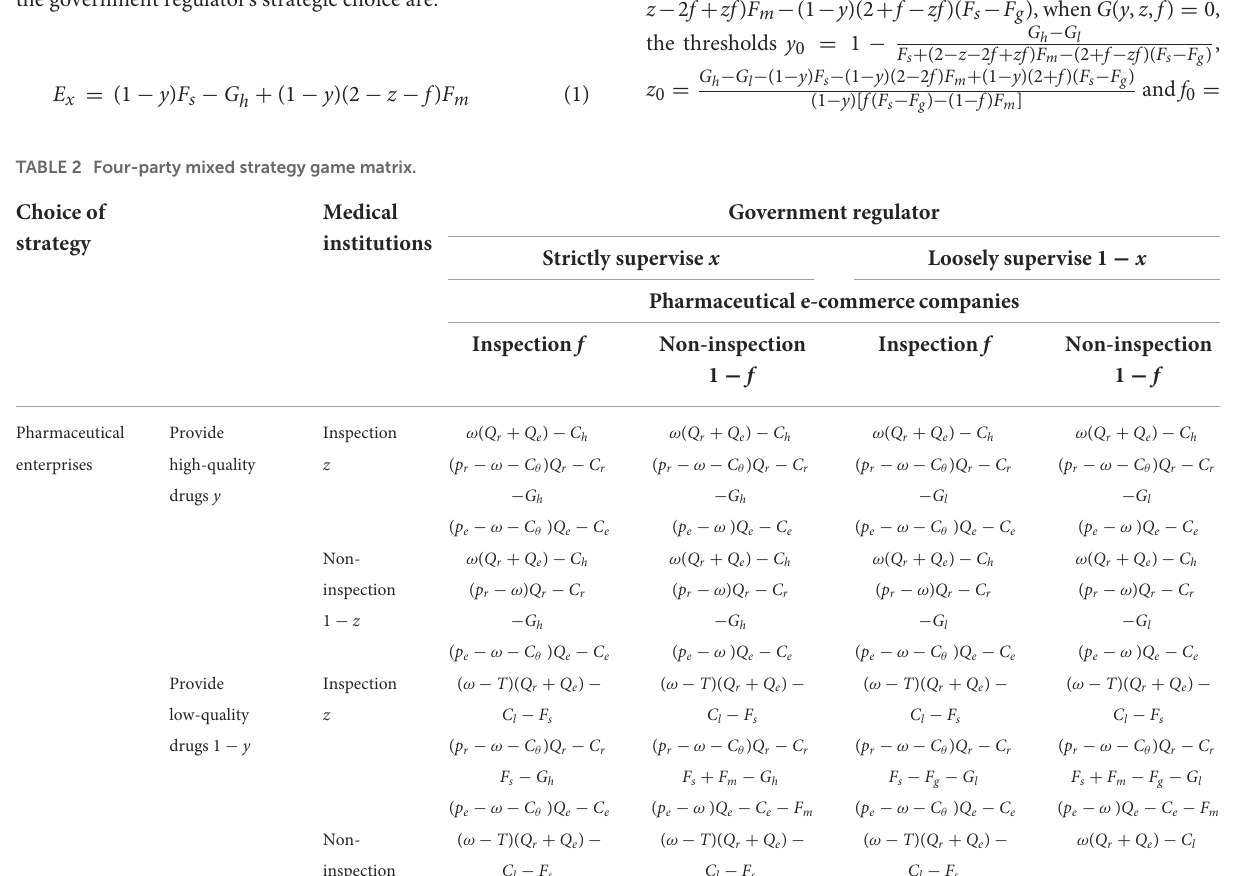
TABLE 2 Four-party mixed strategy game matrix. Choice of